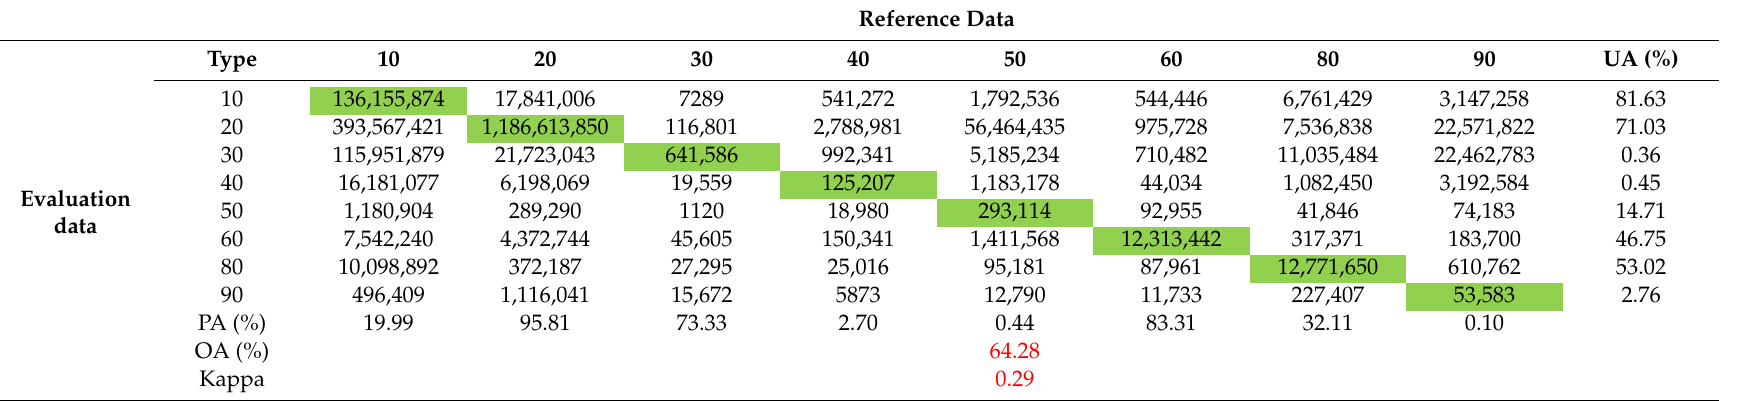
Table 7. Confusion matrix between FROM_GLC2015 and GLC_FCS30-2015 (FROM_GLC2015 provides the reference data). Reference